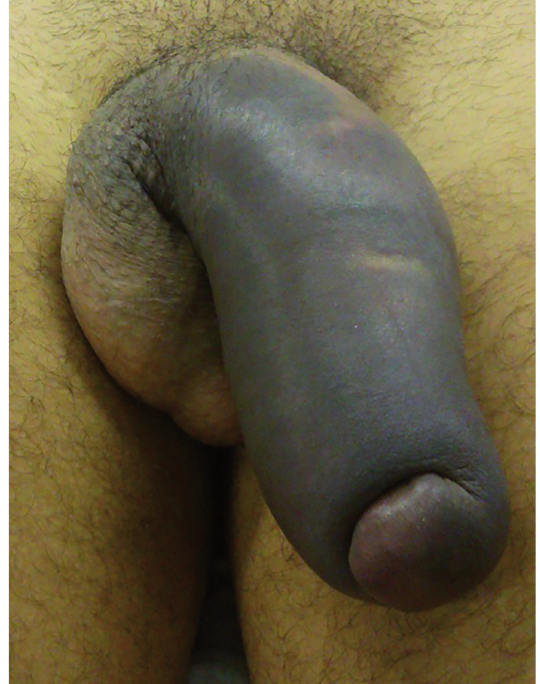
Figure 2 - Tipical eggplant aspect in a patient with penile fracture and urethral injury.